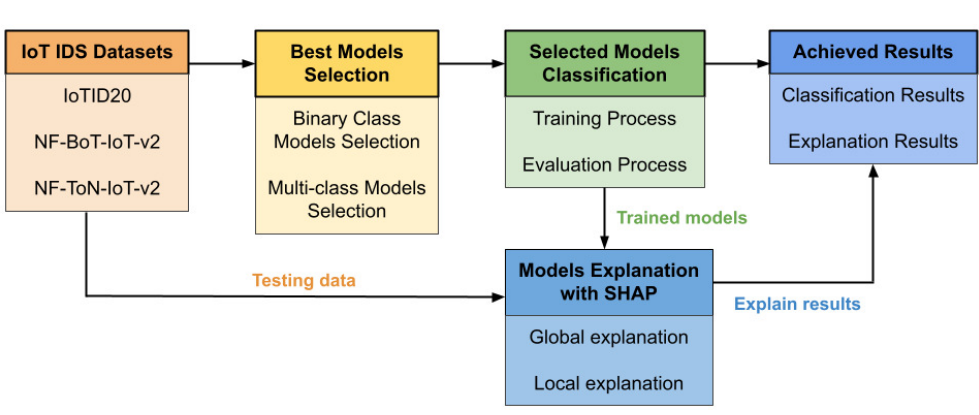
Figure 3. The main concept of the proposed